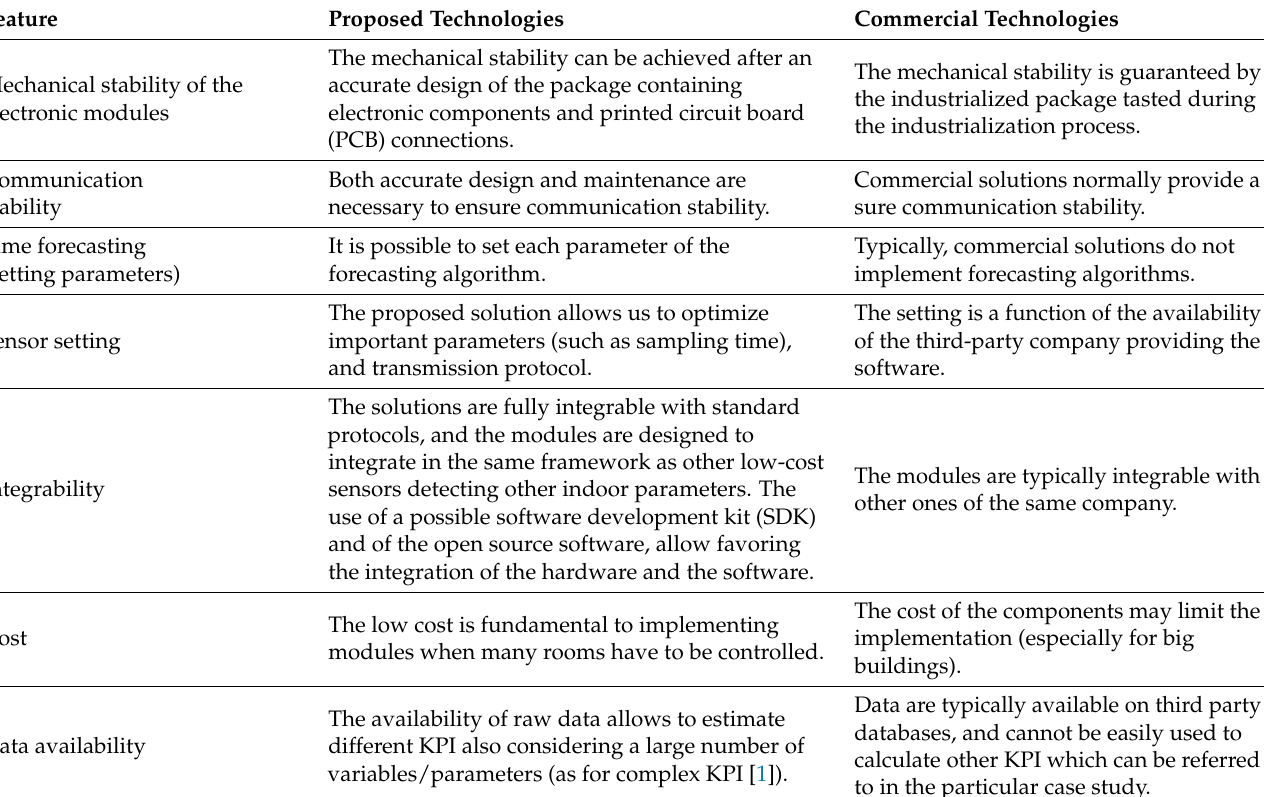
Table 2. Comparison with commercial